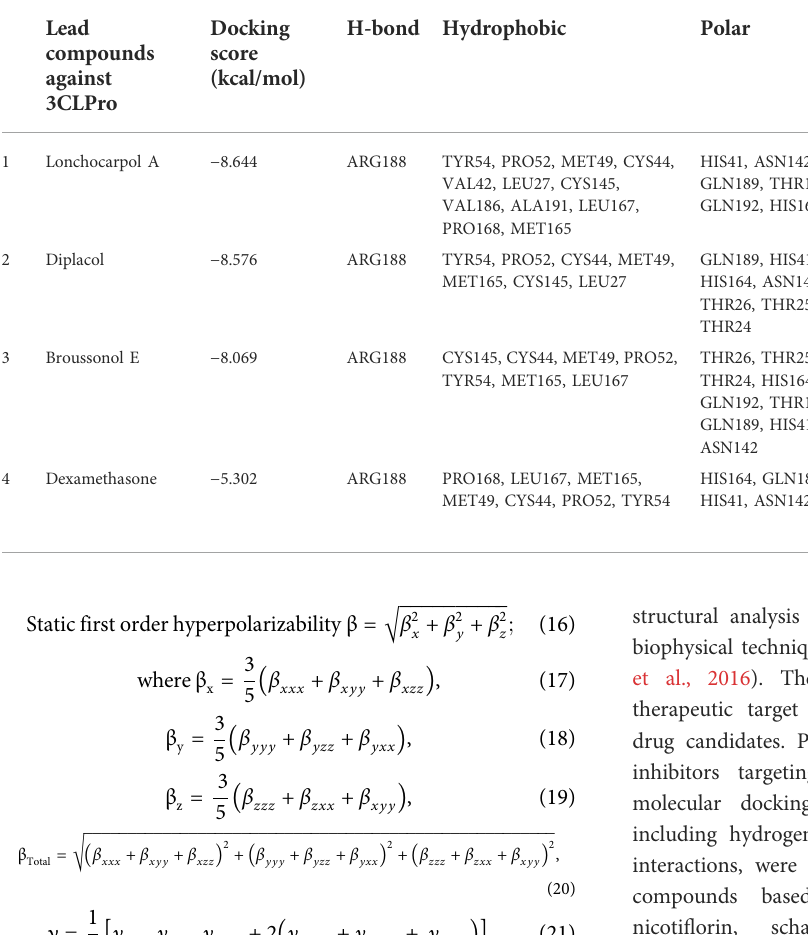
TABLE 6 Molecular interaction pro fi ling and docking score of top four